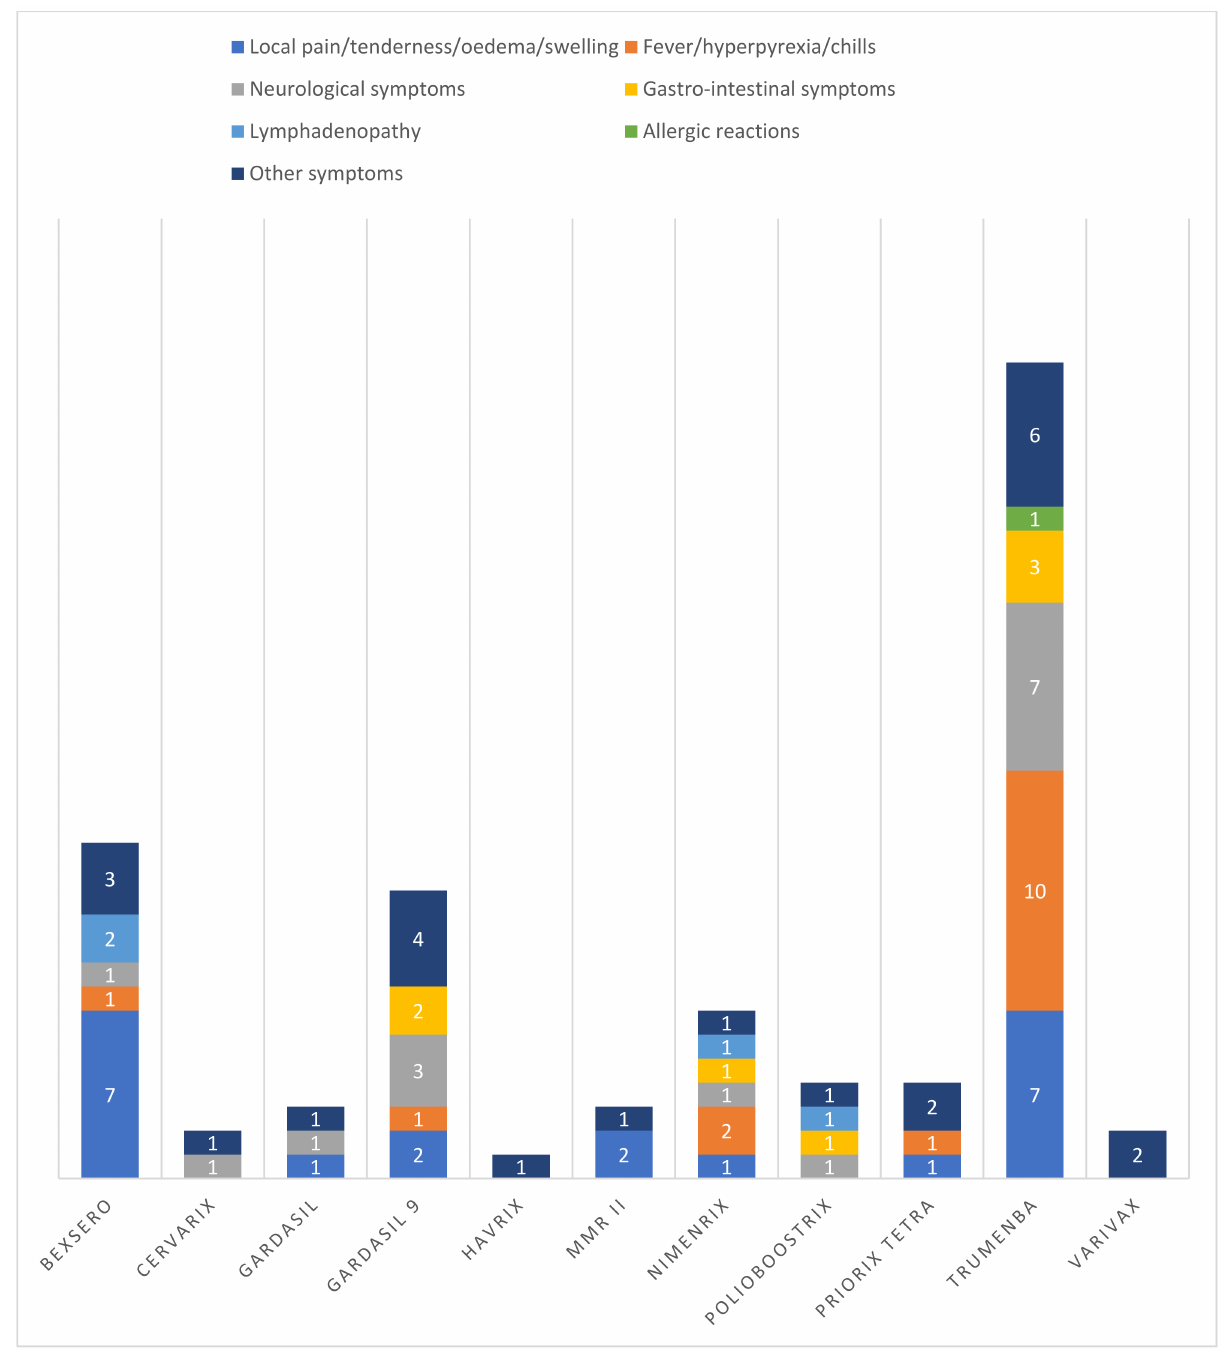
Figure 2. Signs and symptoms described in AEFIs reports, divided by vaccine. As for the 13 serious AEFIs classified as vaccine related, 2 of them (15.4%) occurred after vaccination with Bexsero, 2 (15.4%) after vaccination with Nimenrix, 1 (7.69%) after vaccination with Polioboostrix, 7 (53.8%) after vaccination with Trumenba and 1 (7.69%) after vaccination with